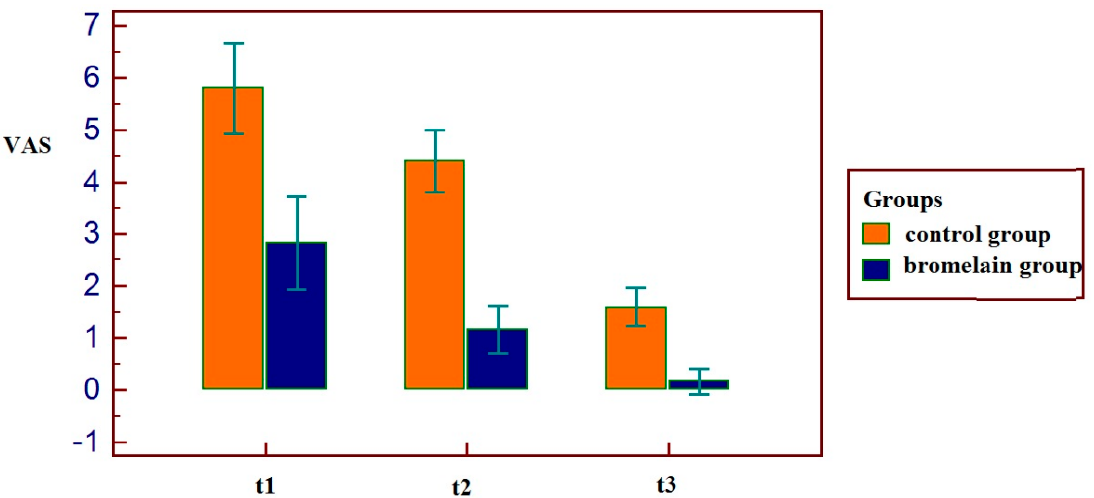
Figure 5. Decrease of pain measured with VAS in all patients. Lower results are observable in patients with bromelain prescription.